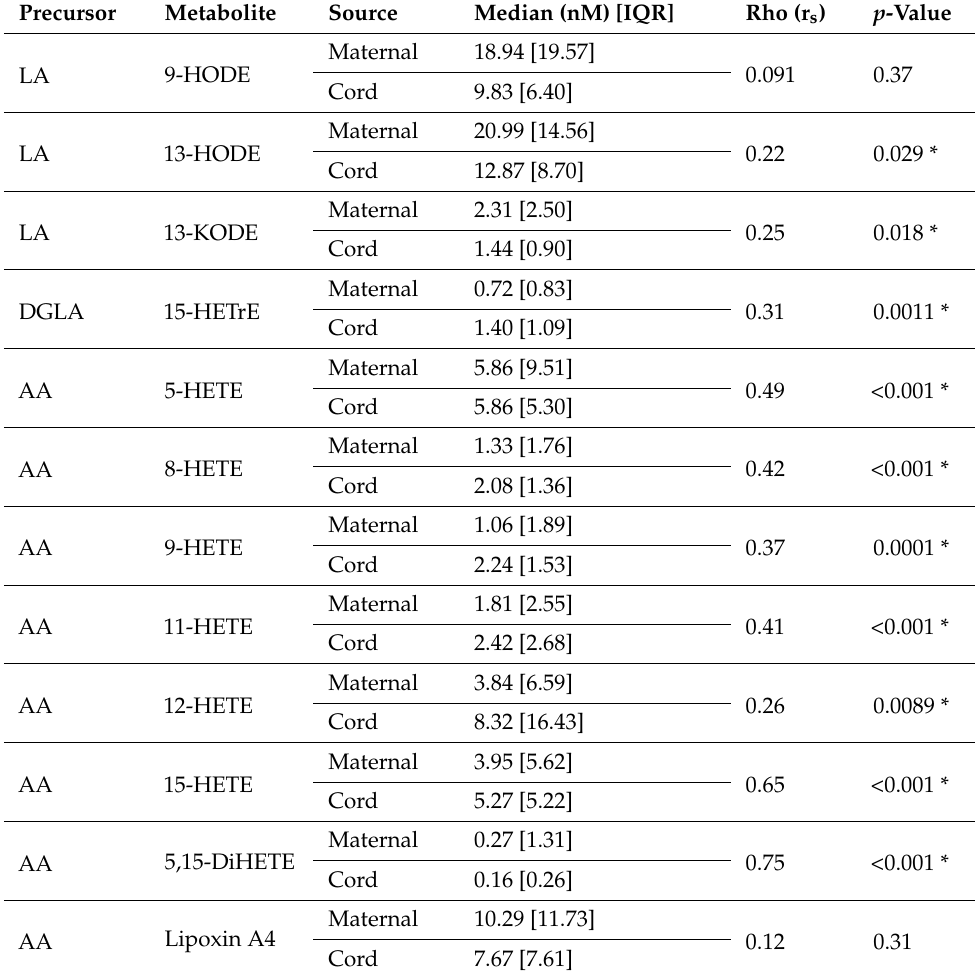
Table 5. Maternal and cord oxylipin concentrations and correlations for n-6